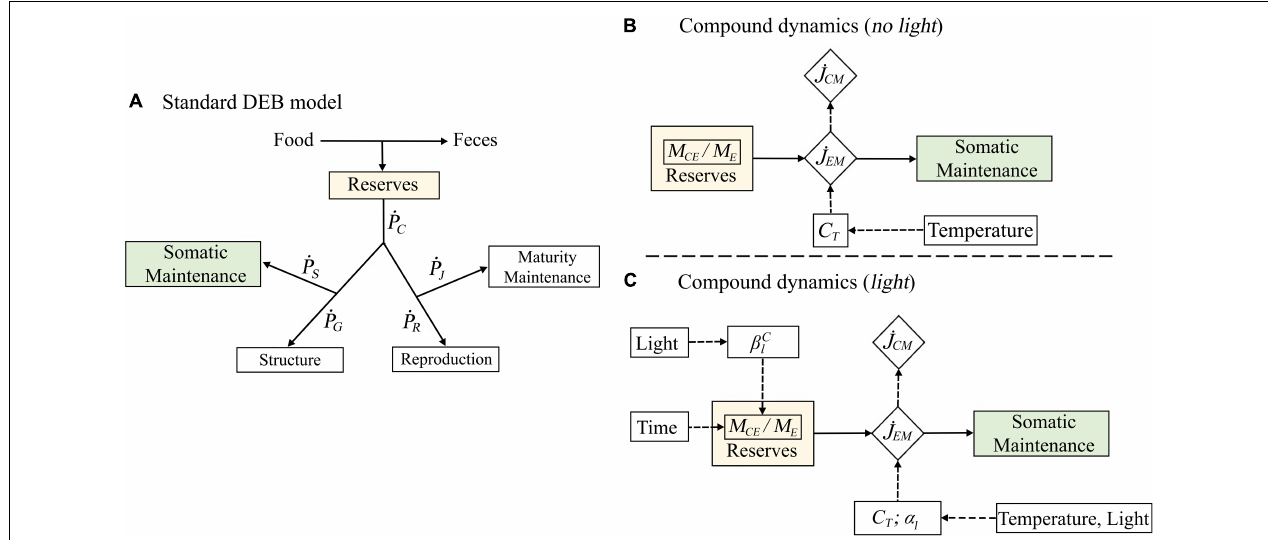
FIGURE 2 | Schematic representation of the three steps implemented for the DEB model parametrization. The components of the standard DEB model that are used to predict the reduction of compounds in time are indicated as green and yellow rectangles (A) . The control model describes how the temperature correction factor ( C T ) affect the flux of compounds ( ˙ J CM ) and the total outflux of energy from the reserves for maintenance purposes ( ˙ J EM ) (B) . The second DEB model describes how the temperature correction factor ( C T ) and two light parameters ( α l ; β C l ) affect the rate of decrease of compounds. However, here both ˙ J EM and ˙ J CM are time-dependent, therefore, affecting the ratio of compounds in the reserves ( M CE / M E ) and the total outflux of energy for maintenance ( ˙ J EM ) (C)